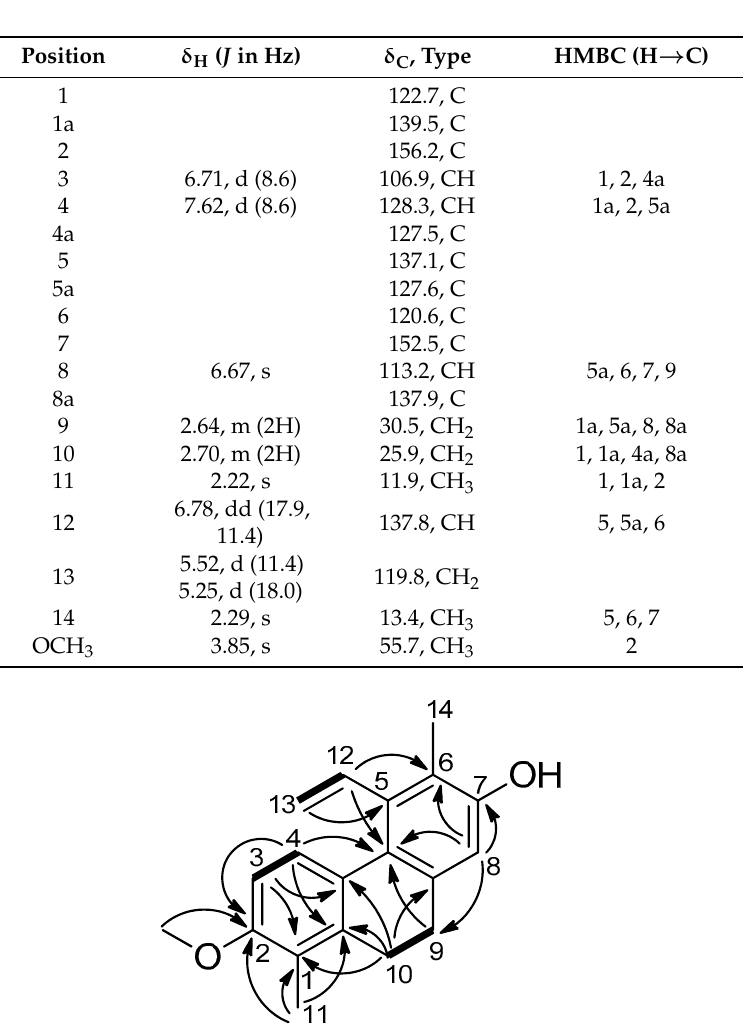
Table 1. NMR spectroscopic data for compressin A (Compound 1 ) (500 MHz ( 1 H), 125 MHz ( 13 C), δ in ppm, CDCl 3 ).